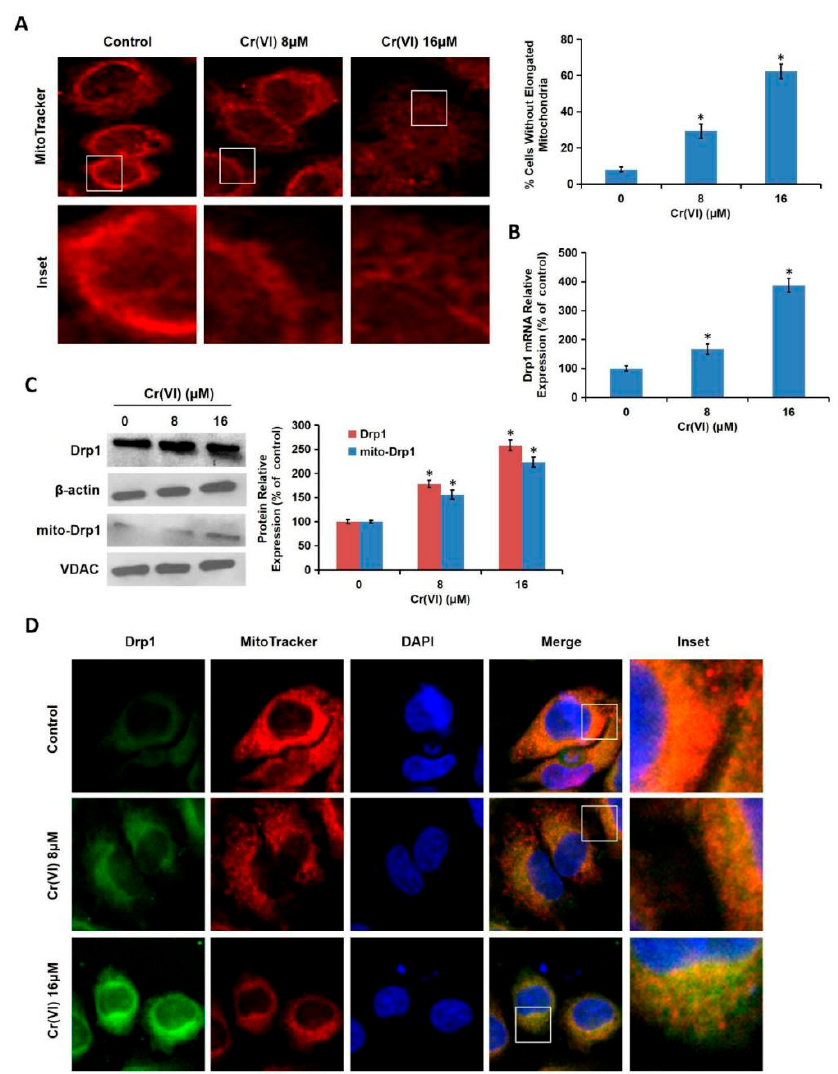
Figure 4. Cr(VI) caused mitochondrial fragmentation. L02 hepatocytes were treated with different concentrations of Cr(VI) (0, 8, 16 µM) for 24 h. ( A ) Mitochondrial morphology was determined using Mitotracker Red by confocal microscope. The % of cells without elongated mitochondria was calculated. ( B ) Drp1 mRNA expression was determined using qRT-PCR. ( C ) Total and mitochondrial Drp1 protein expressions were detected using Western blotting analysis. Voltage-dependent anion channel 1 (VDAC1) served as the loading control of mitochondrial protein. ( D ) Drp1 mitochondrial translocation was observed under a confocal microscope. * p < 0.05, compared with the control